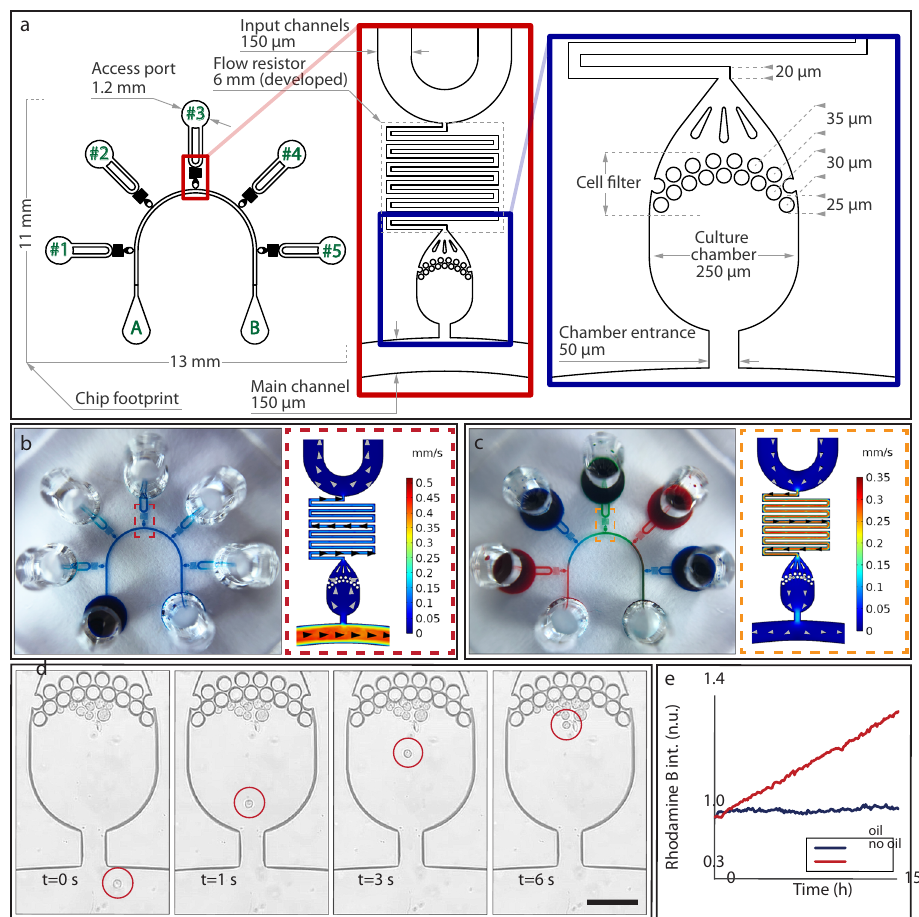
Fig. 1 Outline of the VersaLive micro fl uidic platform. a Layout of the micro fl uidics device with fi ve independent chambers. On one side, all chambers are connected to the main channel that develops from port A to port B of the schematics. Fluids can be directed to each chamber independently by dedicated ports (ports #1 to #5 on the schematics). The serpentine fl ow resistor prevents shear stress to the cells during the device operations. b , c Modes of operation of VersaLive and their fi nite element simulations in COMSOL Multiphysics software (dashed inset). In the “ perfusion ” single-input mode ( b ), the main channel is exploited to deliver the same medium to all chambers at the same time. Multi-input mode ( c ) exploits the dedicated ports to deliver different inputs (i.e., media, chemicals) to each chamber avoiding cross-contaminations. d During cell loading, the cell suspension fl ows through the main channel and into the chambers. Once in the chamber, cells slow down and are eventually stopped by the fi lter features as predicted in the velocity pro fi le of the simulation. Scale bar, 150 µ m. e Solvent evaporation at the reservoirs was observed to increase the solute concentration of the channel content during perfusion. The effect was completely removed by the addition of a layer of mineral oil at the reservoirs. In the plot one single representative run is